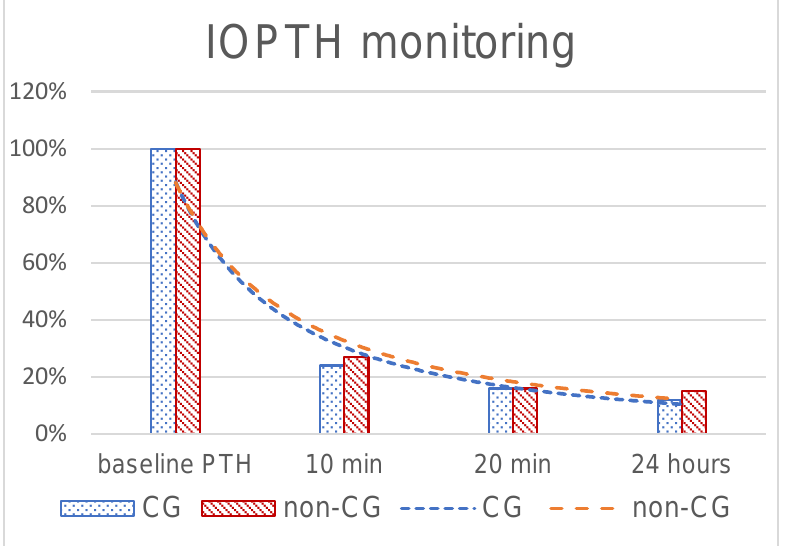
Figure 3. IOPTH monitoring of the PTH drop intraoperatively with trend lines for both groups, CG and